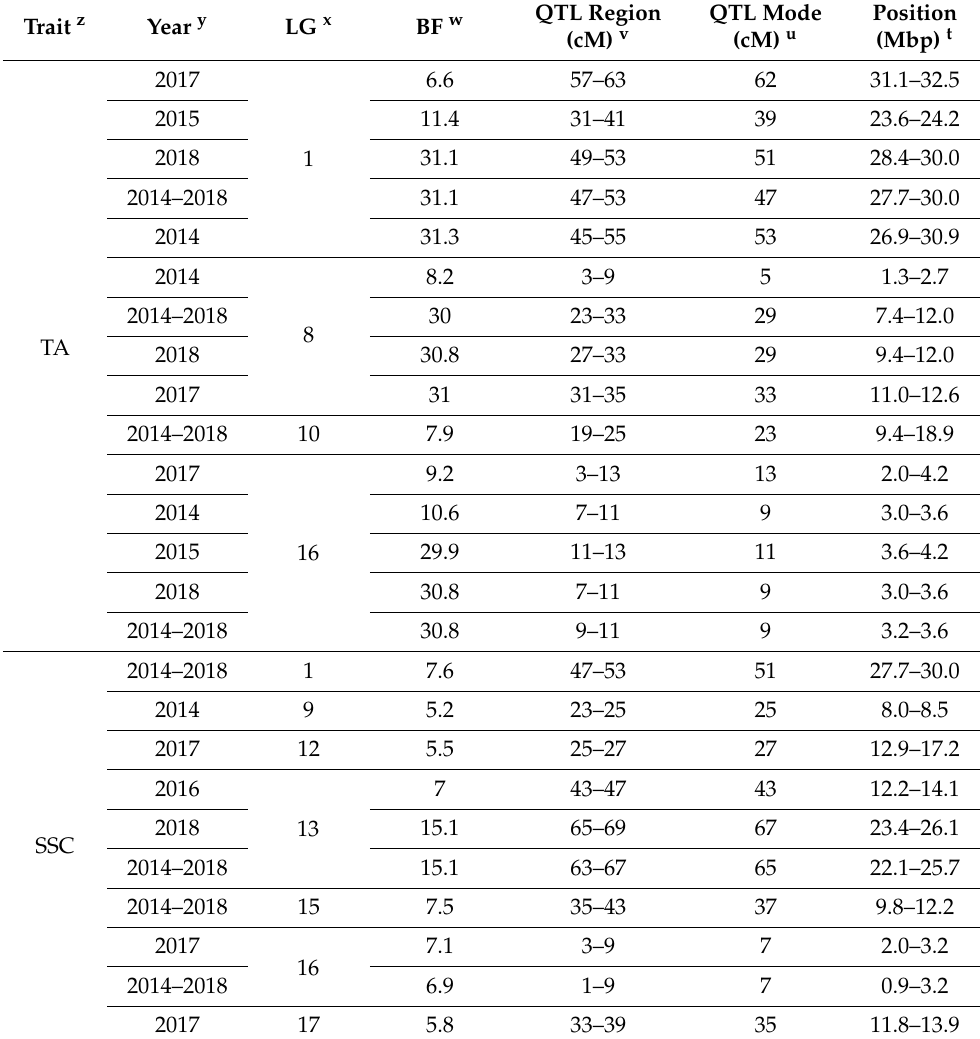
Table 1. Summary of TA and SSC QTL analysis results across years and datasets. QTLs with strong (BF > 5) to decisive (BF > 10) evidence are reported.